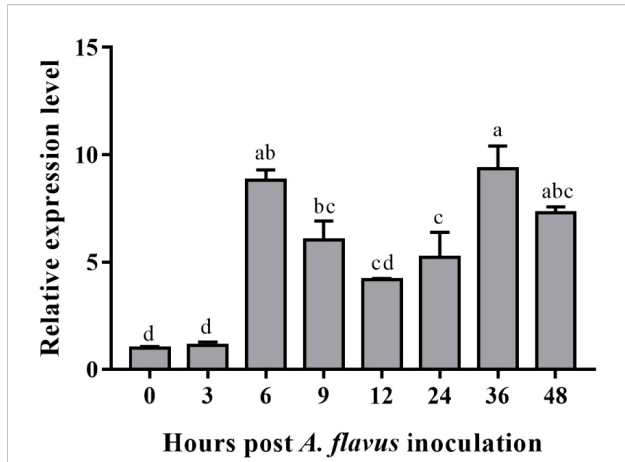
FIGURE 7 Quantitative expression of GUS gene in response to A. fl avus infection. The GUS gene recorded an increased expression at 6h post inoculation and maintained higher expression even after 48 hours. The